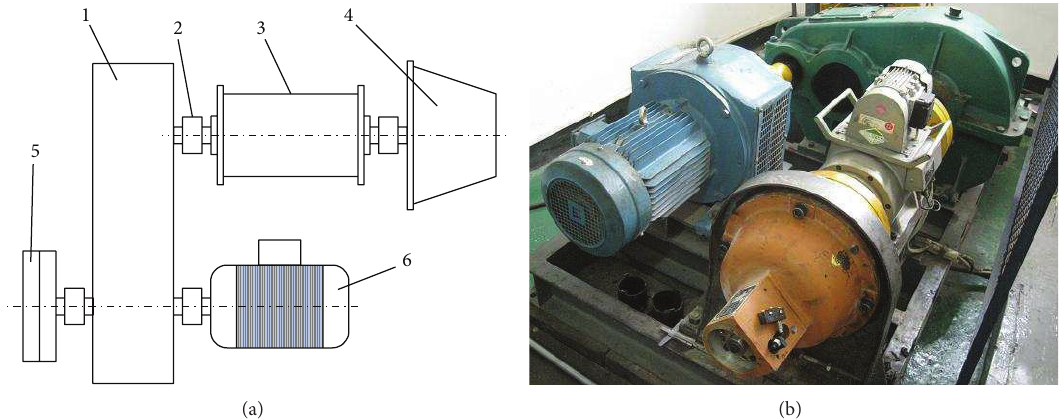
Figure 3: Experiment platform, where 1 is a gear box, 2 is a shaft coupling, 3 is sensor system of rotation speed and catching torque, 4 is an antifalling safety device, 5 is an electric motor, and 6 is an inertia load block.